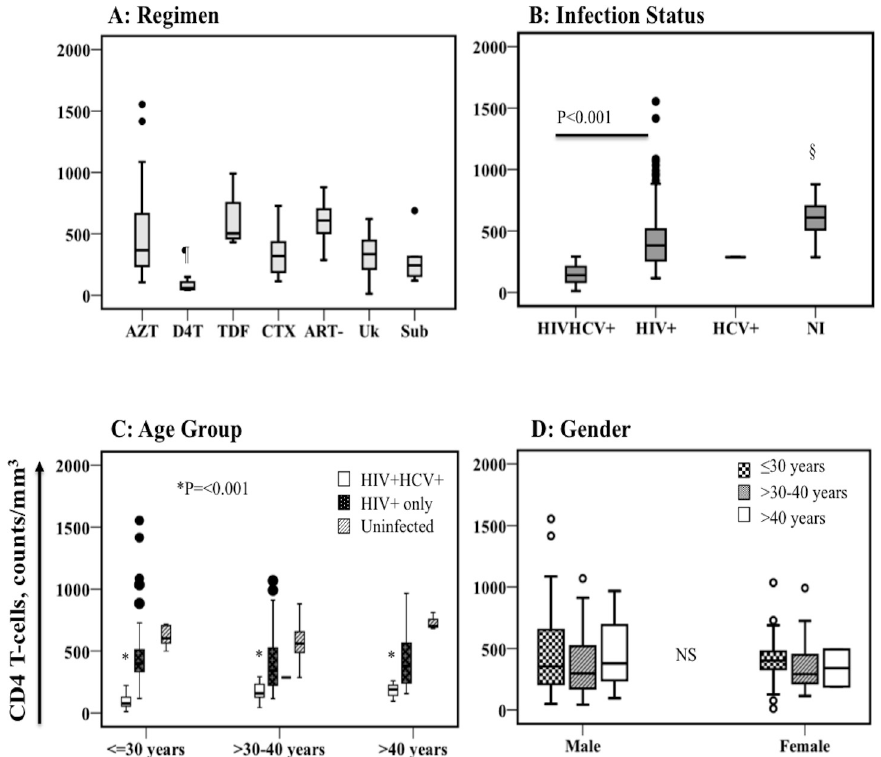
Fig 1. CD4 Counts across various categories of heroin injectors. CD4 T-cells are compared between treatment arms of injectors (A). ¶ Counts are significantly lower for the D4T- arm than for the AZT arm (p = 0.004), TDF (p = 0.005) or the ART- (p < 0.001) arm and lower for the sub-optimal ART than ART- (p = 0.023) arm. All subjects in the ‘ ART- ’ arm were not infected (NI) by either virus. Mean CD4 counts are compared between infection statuses (B). These are significantly lower for co-infected than HIV-1 mono infected injectors as shown. §Shows significantly lower CD4 counts for HIV mono-infected than NI injectors (p = 0.002). CD4 data is compared between age groups of the different infection statuses (C). No significant (NS) difference was observed. * Co-infected injectors had much lower CD4 levels compared to other infection categories in any age group. Only one injector was HCV mono-infected (horizontal bar in the > 30 – 40 years category). CD4 Counts were not significantly different between genders of injectors (D). ART, antiretroviral treatment; CTX, cotrimoxazole (septrin); ART-, No ART; Uk, unknown ART status; Sub, sub optimal